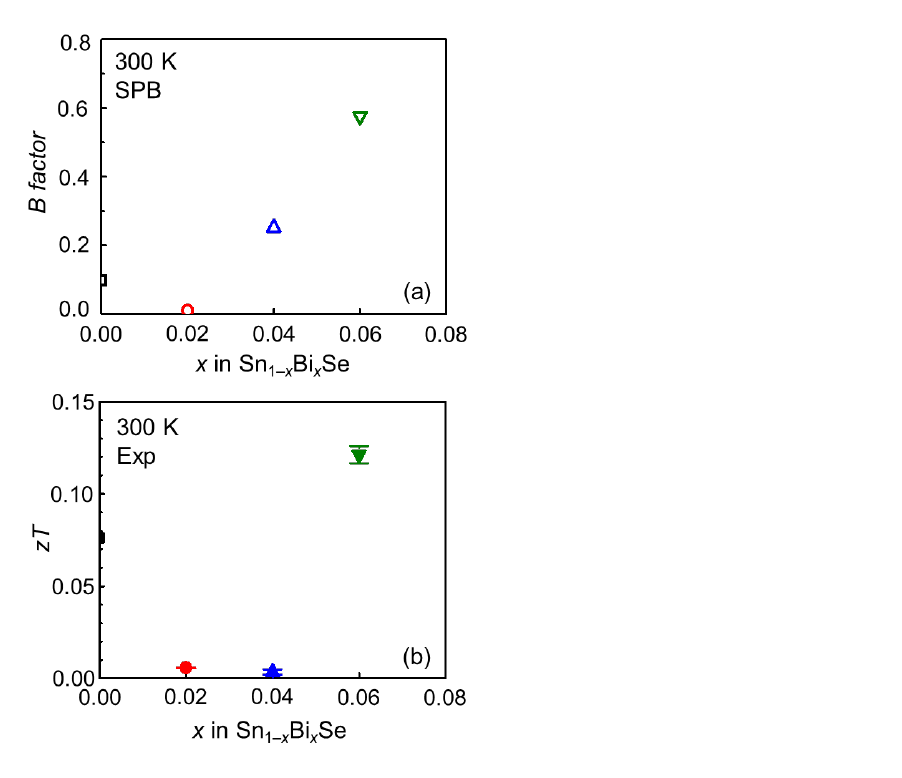
Figure 4. ( a ) Calculated B- factor varying with x in Sn 1 − x Bi x Se ( x = 0.00, 0.02, 0.04, and 0.06) at 300 K, ( b ) experimental zT varying with x in Sn 1 − x Bi x Se ( x = 0.00, 0.02, 0.04, and 0.06) at 300 K [18].